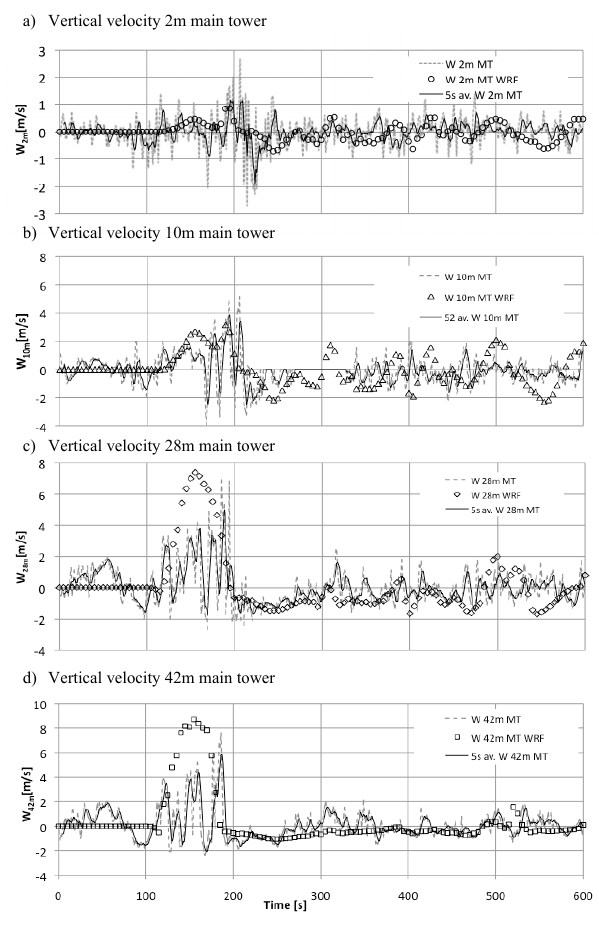
Fig. 9. As in Fig. 8 except for vertical wind